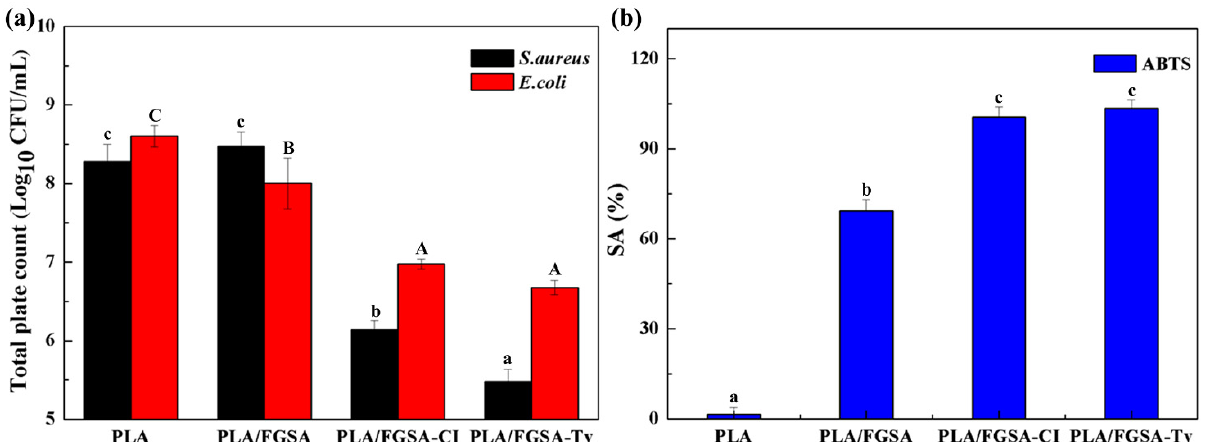
Figure 6. The bacteria populations in different groups were studied and shown at the end of storage ( a ). Antioxidant property of films (PLA, PLA/FGSA, PLA/FGSA-CI, and PLA/FGSA-Ty) for ABTS radical scavenging ( b ). Different subscript lowercase letters and uppercase letters indicate that the means are significantly different ( p < 0.05).